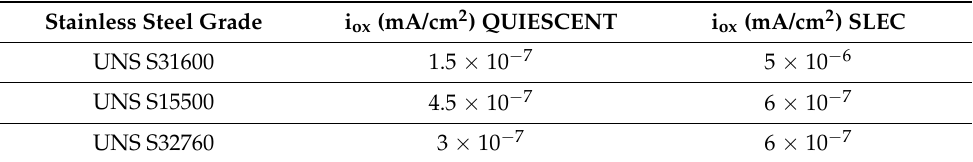
Table 12. Average exchange current densities for the cathodic reactions on stainless steels in quiescent and SLEC conditions.